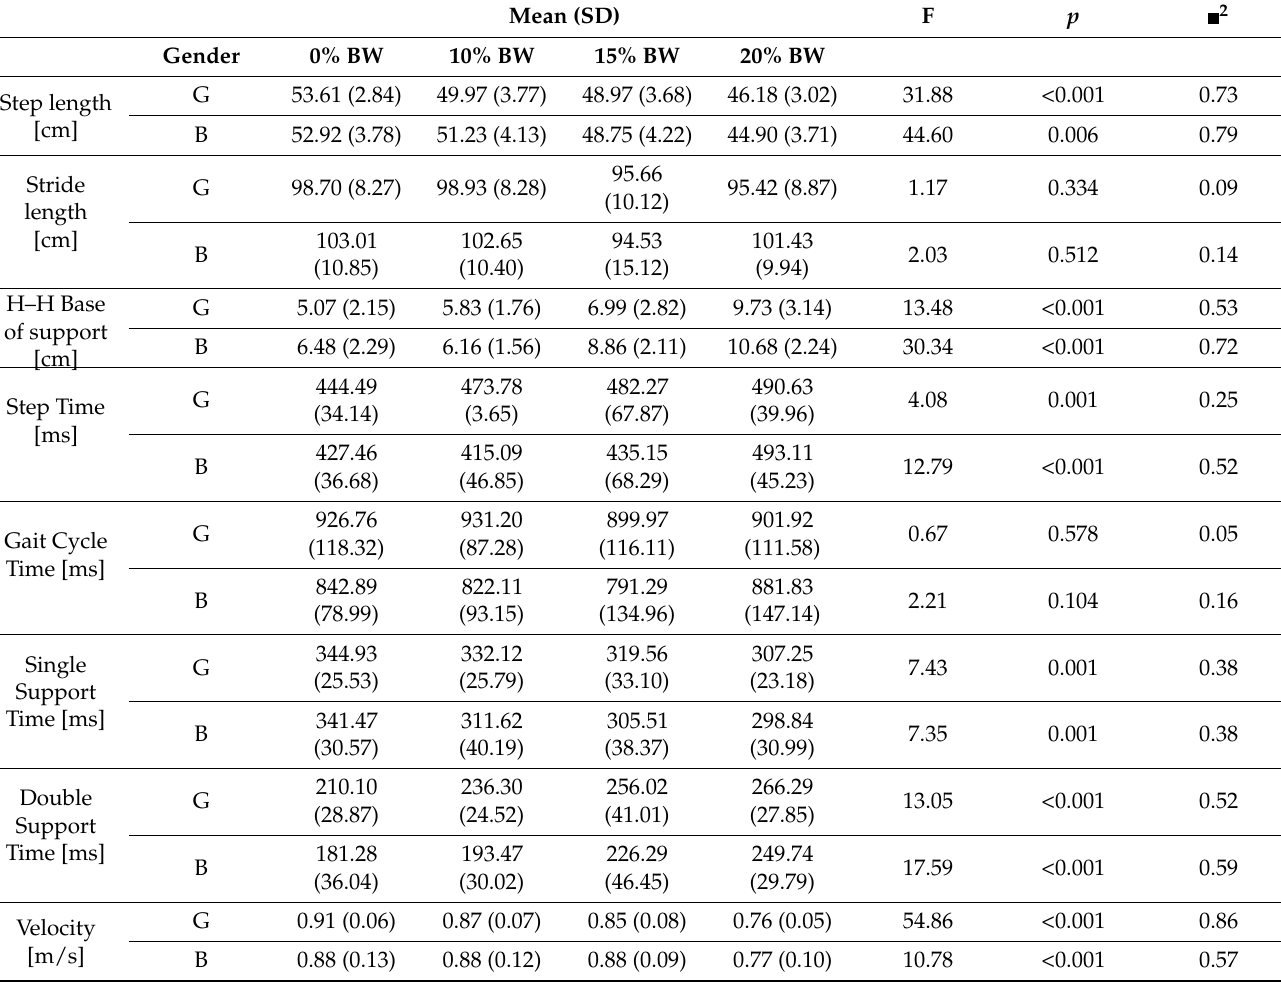
Table 2. Inferential statistics of the spatiotemporal parameters of the gait in different loading conditions. Mean (SD) F p